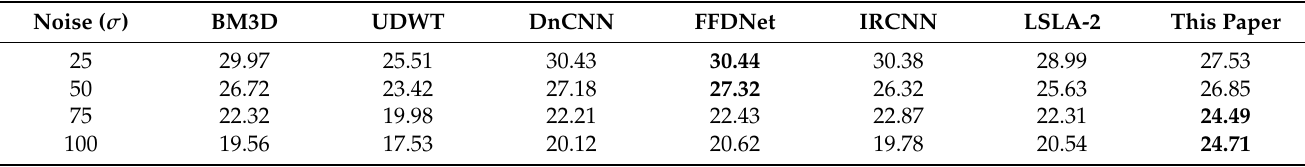
Table 1. PSNR values of the different methods.